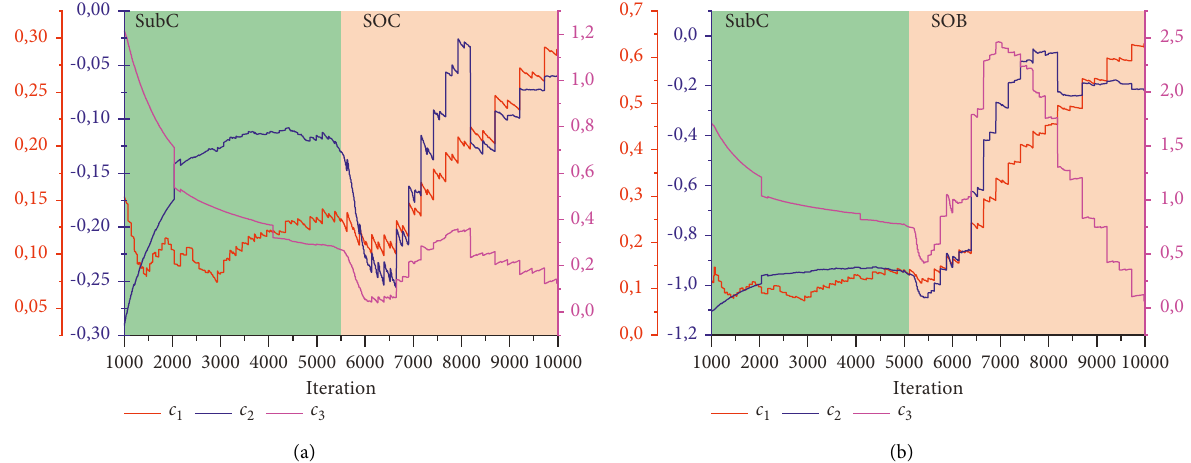
, i � 1 , 2 , 3) for the sandpile cellular automata. (a) Standard rules of the Manna model and (b) i